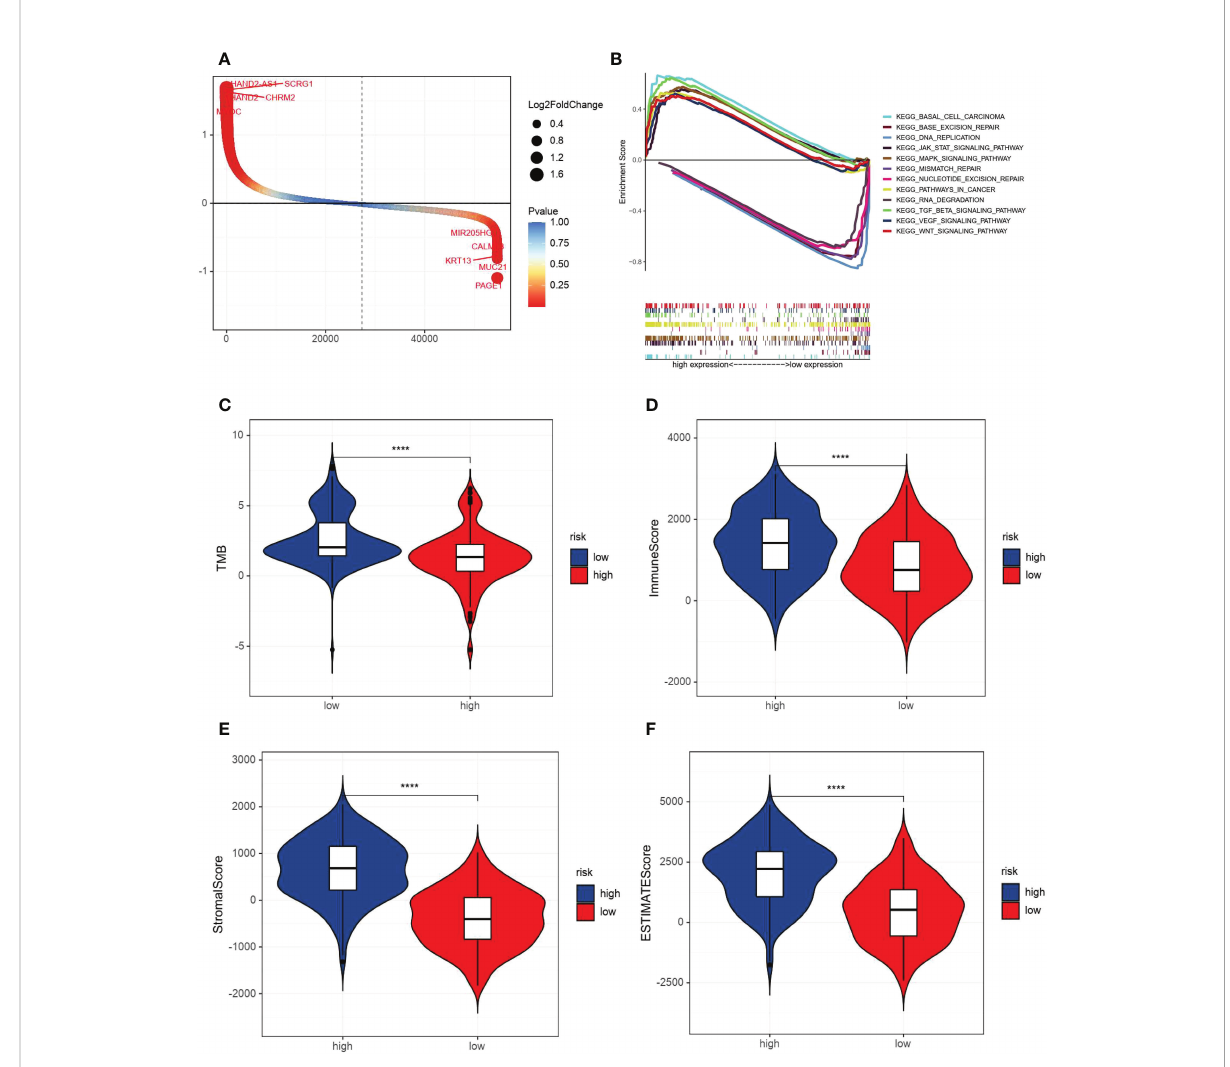
FIGURE 4 Analysis of DEGs, GESA and correlation with TMB and immune/stromal scores. (A) DEGs according to VM index. (B) Gene set enrichment analysis (GSEA) results of the difference enrichment pathways according to VM index. (C) Distribution of TMB according to VM index. (D) Distribution of immune score according to VM index. (E) Distribution of stromal score according to VM index. (F) Distribution of ESTIMATE score according to VM index. **** means